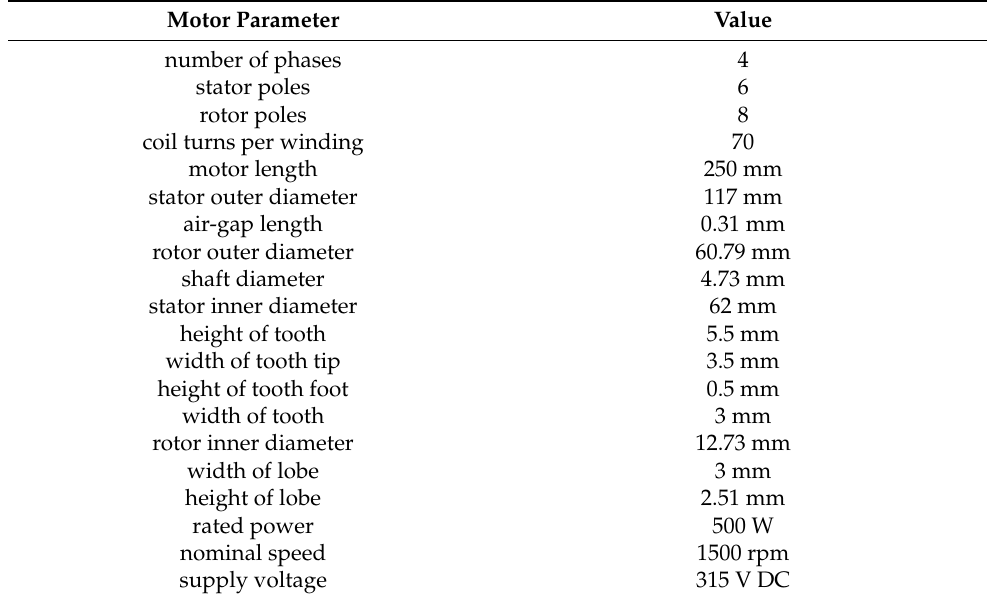
Table 1. SRM Motor